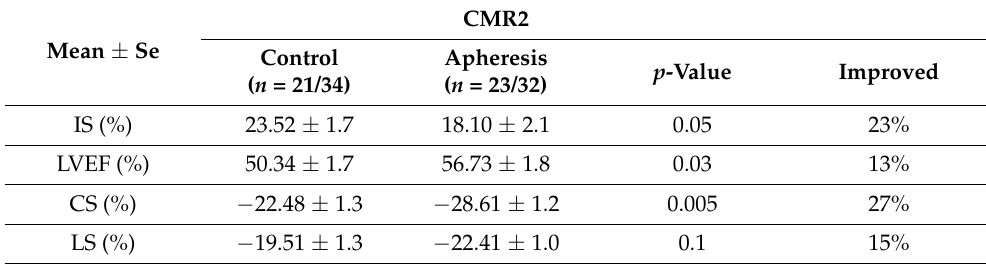
CMR2 = second Cardio Magnetic Resonance, CS = Circumferential Strain, IS = Infarc Size, LS = Longitudinal Strain, LVEF = Left Ventricular Ejection